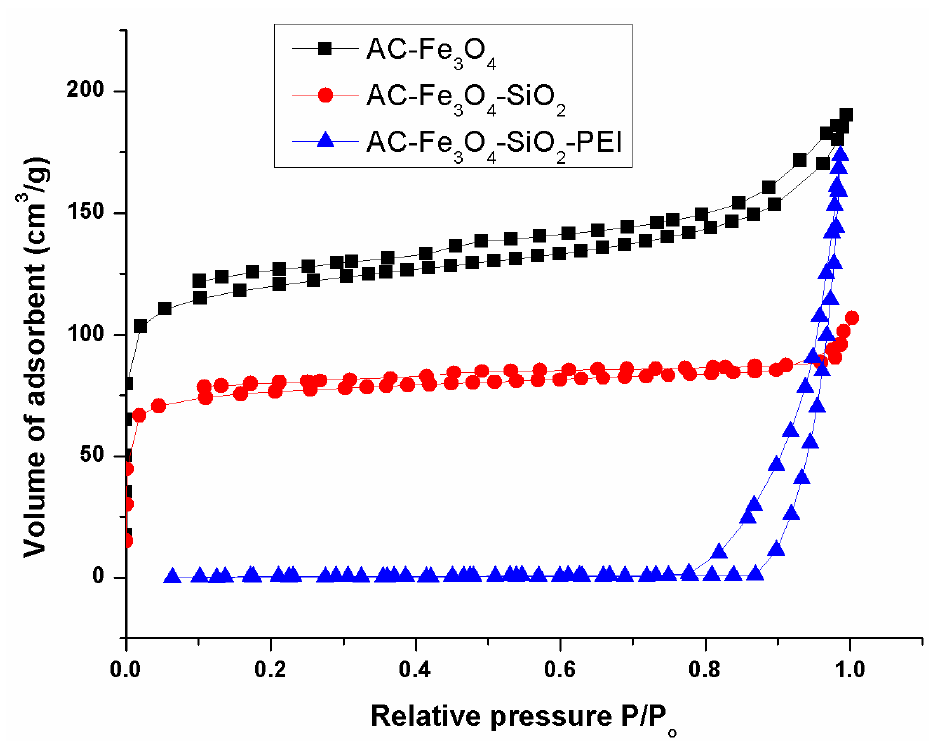
Figure 2. N 2 adsorption/desorption isotherms of AC-Fe 3 O 4, AC-Fe 3 O 4 -SiO 2, and AC-Fe 3 O 4 -SiO 2 -PEI. The X-Ray-diffraction patterns for AC-Fe 3 O 4 , AC-Fe 3 O 4 -SiO 2, and AC-Fe 3 O 4 -SiO 2 -PEI are presented in Figure 3. AC-Fe 3 O 4 and AC-Fe 3 O 4 -SiO 2 exhibited six diffraction peaks at